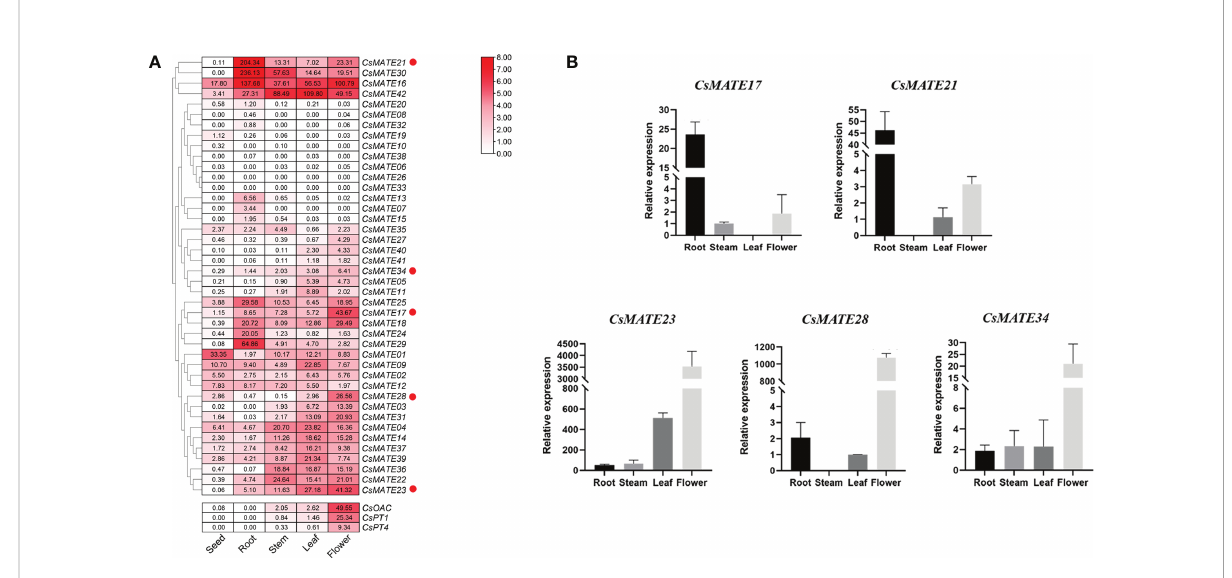
FIGURE 4 Expression of CsAMTEs and cannabinoid biosynthetic genes. (A) Expression pro fi le of CsMATEs in seed, root, stem, leaf and fl ower. PFKM values were used to con fi gure the heatmap. Red dots, genes selected for expression veri fi cation. CsOAC , olivetolic acid synthase ; CsPT1 and CsPT4 , prenyltransferase 1 and 4 gene, repectively. (B) quantitative reverse transcription PCR veri fi cation. y-axis, relative gene expression normalized to CsEF1-alpha . x-axis, different tissues. Data, mean ±